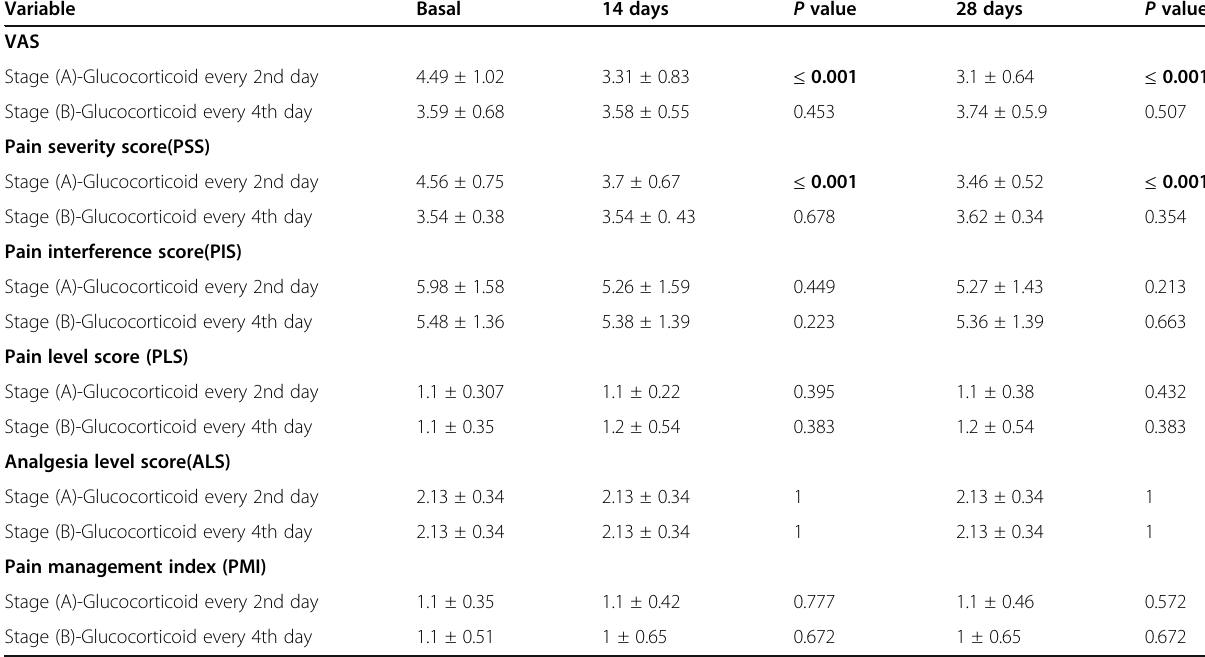
Table 2 Pain measurement variables (stage analysis) Variable